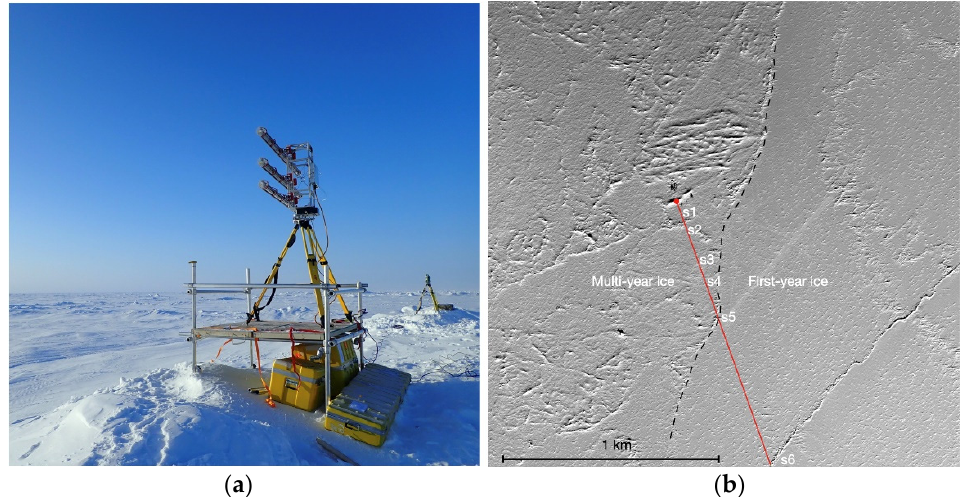
Figure 2. ( a ) GPRI stationed on top of a ridge in the Beaufort Sea during the ICEX 2020 campaign. ( b ) Area overview of the ice camp and surrounding sea ice identified with WorldView-II imagery. The red line in ( b ) indicates look direction during the stare-mode acquisition. s1–s6 are strong scatterers highlighted in the analysis (see the text for details). s5 is on the boundary between first- and multi-year sea ice, which is highlighted with a dashed